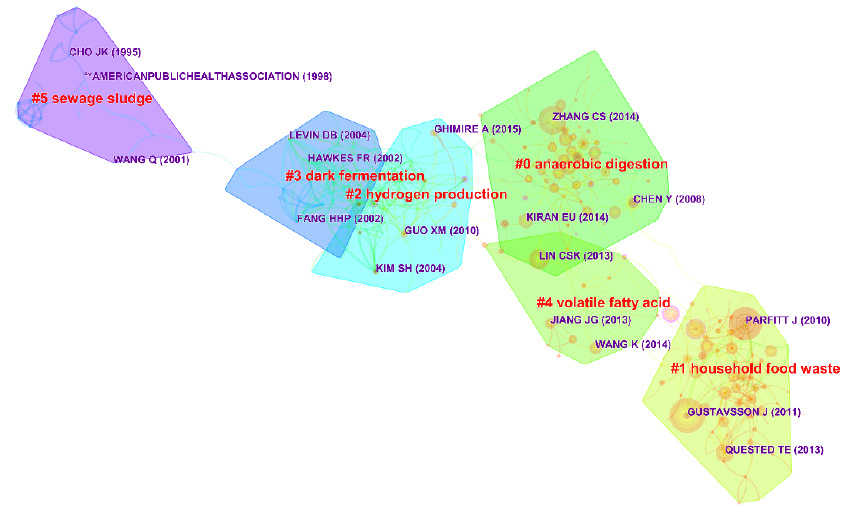
Figure 8. Knowledge domains map for reference co-citation.